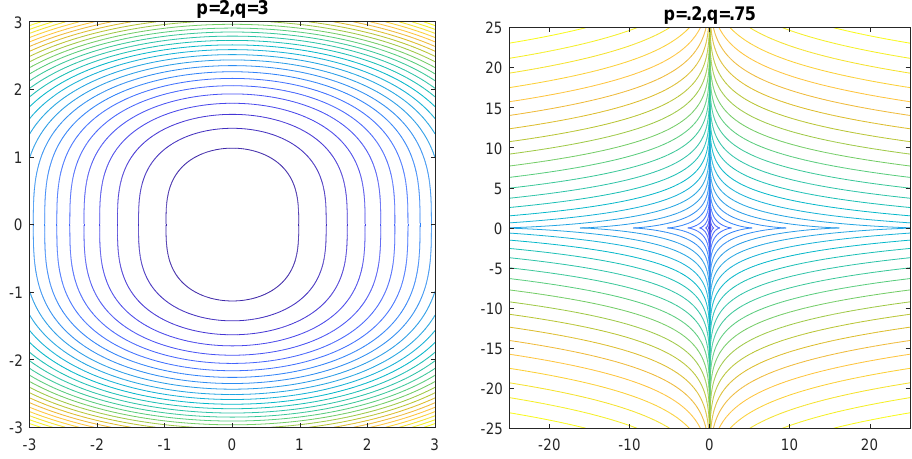
Figure 10. C [ p , q ] ( r ) for various values of [ p , q ] and running [ p , q ] -radius r . ( r ) as r changes we call { C ( r ) , r > 0 } a dynamic Due to change of shape of C [ [ p , q ] p , q ] family of [ p , q ] -circles. Corresponding l p , q -circle numbers are normalizing constants of certain probability density generating